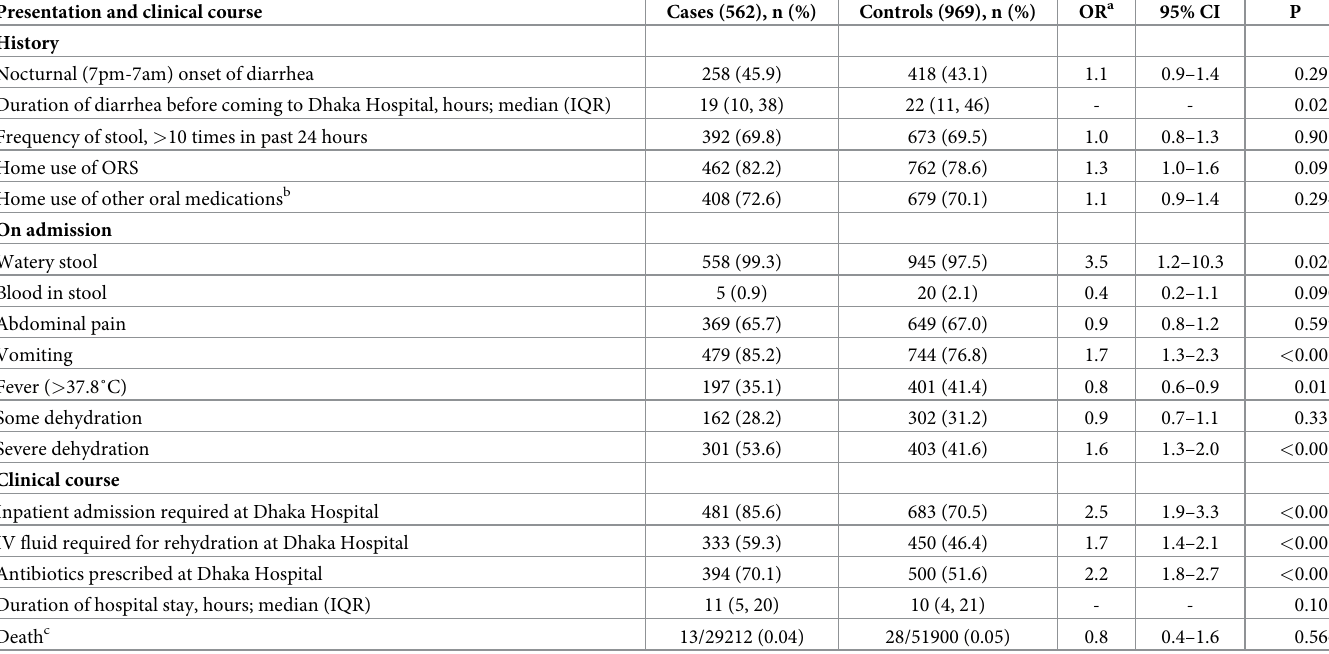
Table 5. Hospital presentation and clinical course in DDSS-enrolled patients treated at icddr,b Dhaka Hospital during the epidemic (cases) compared to the patients treated during the comparison period (controls).